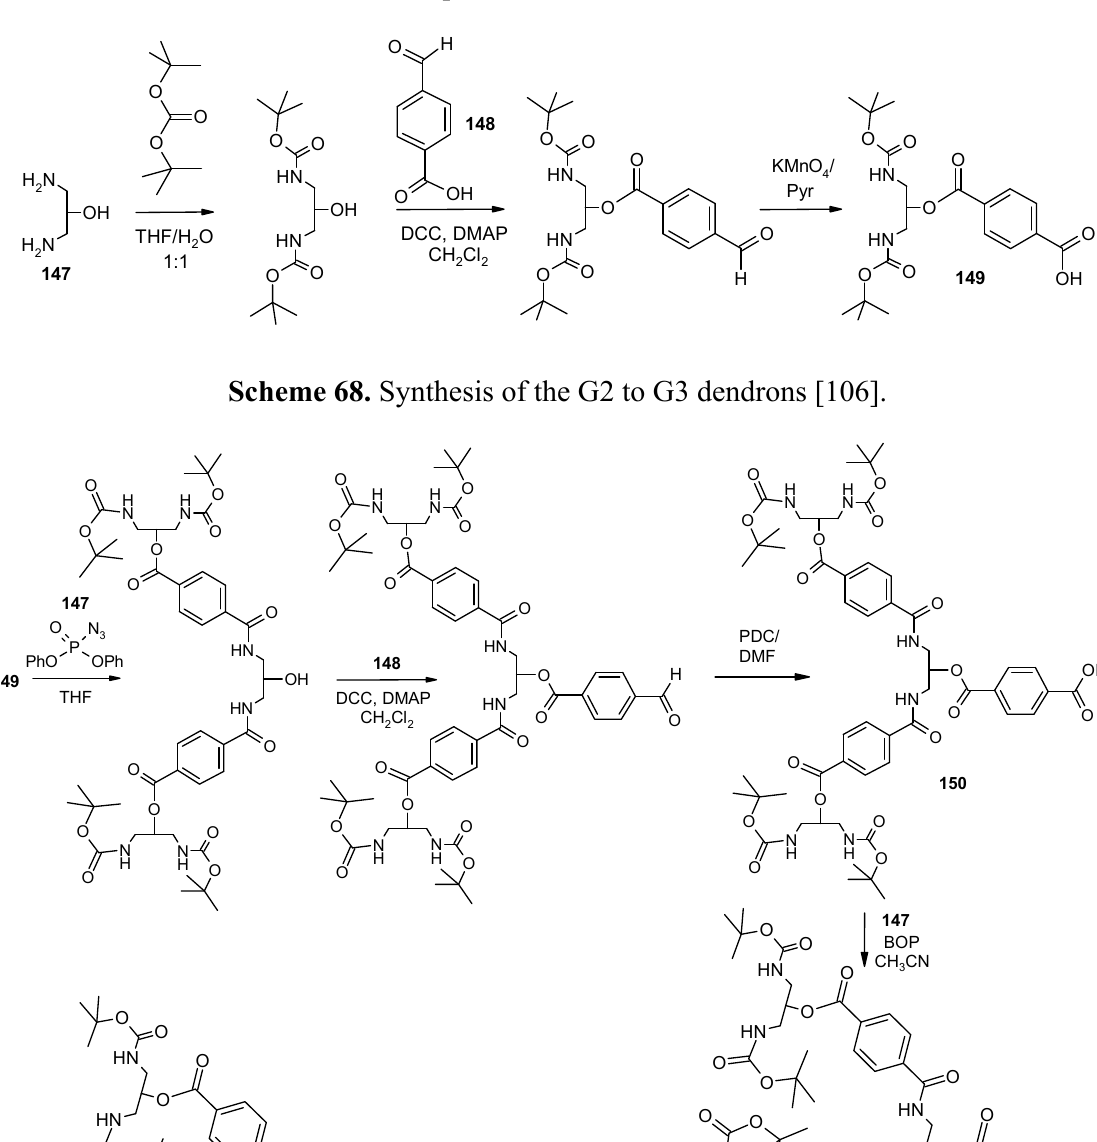
Scheme 67. Preparation of the AB